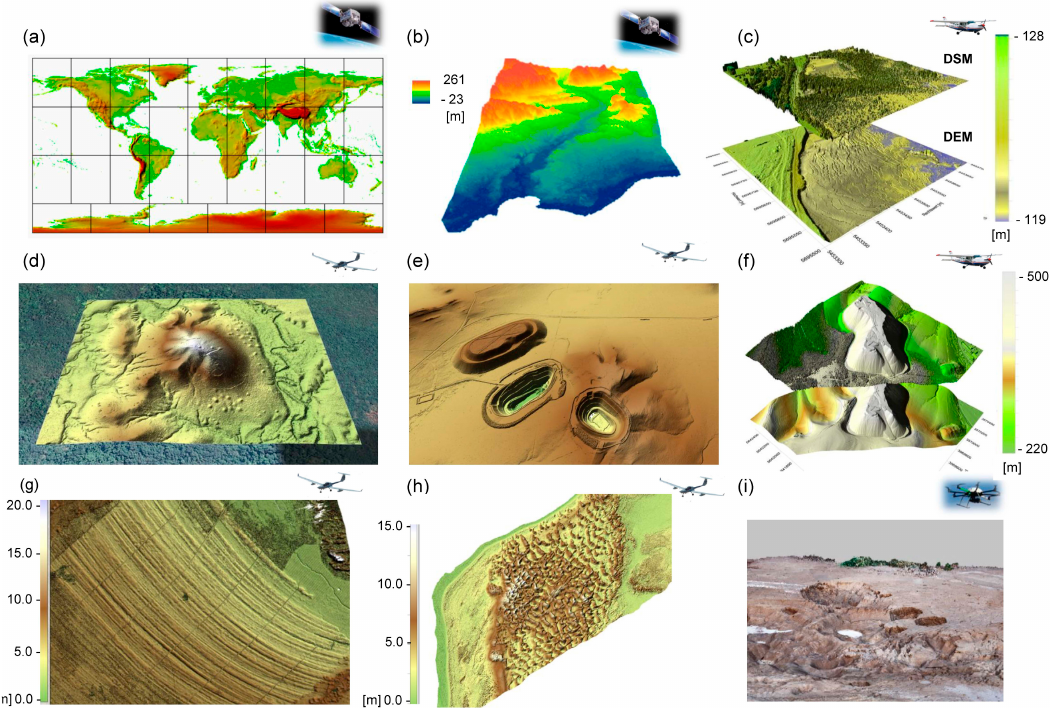
Figure 2. Elevation, terrain and surfaces as crucial characteristics for all geomorphological landforms can be monitored with different air- and spaceborne RS technologies: ( a ) Digital Elevation Model (DEM)—GTOPO30, ( b ) an oblique, three-dimensional (3D) perspective of the DEM of the downstream area of Wadi El-Ambagi derived from a WorldView-2 stereo pair [75], ( c ) Digital Surface Model DSM and DEM derived from airborne LiDAR, area of reforestation in the former open-cast mining region Lausitz, Germany, ( d ) DEM of a rainforest area in Cape York (Australia) showing mining exploration scars and revealing groups of Brush Turkey mounds (airborne LiDAR—RIEGL Q680i-S), ( e ) 50 cm DEM of a mine site rehabilitation area near Morawa (Australia, airborne LiDAR—RIEGL Q680i-S), ( f ) DSM and DEM derived from airborne LiDAR acquisitions of an open pit mining dump of Wintershall in Germany, (2 km × 2 km, >12 points/m 2 ), ( g ) low resolution DEM of a dunescape in Tasmania (airborne LiDAR—RIEGL Q680i-S), ( h ) 25 cm DEM of sand dunes at the Tubridgi Coast in North West Australia (airborne LiDAR—RIEGL Q680i-S) and, ( i ) a land surface with 3D sinkholes in Israel (UAV).